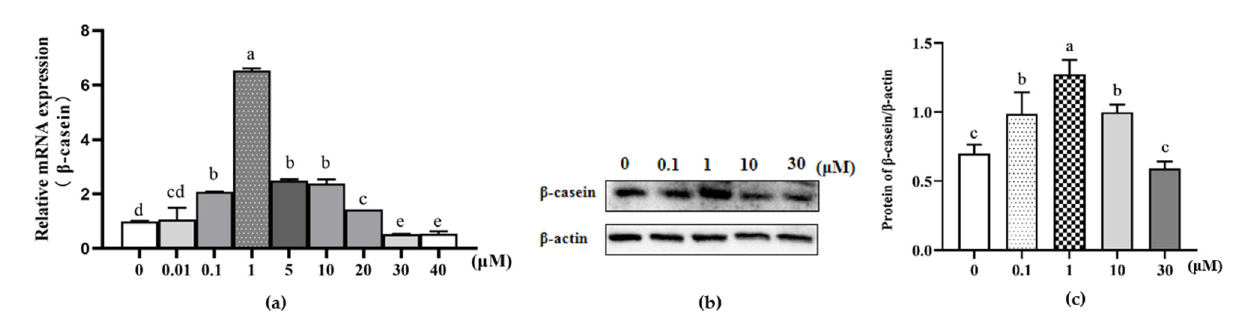
Figure 1. Effects of β -sitosterol on β -casein synthesis in MAC-T cells. ( a ) β -casein mRNA levels determined by qPCR. ( b ) β -casein protein levels detected by Western blotting. ( c ) The ratio of β -casein protein relative to β -actin control. Data are expressed as means ± standard deviation ( n = 3). Different lower-case letters indicate significant differences compared to the control ( p < 0.05).